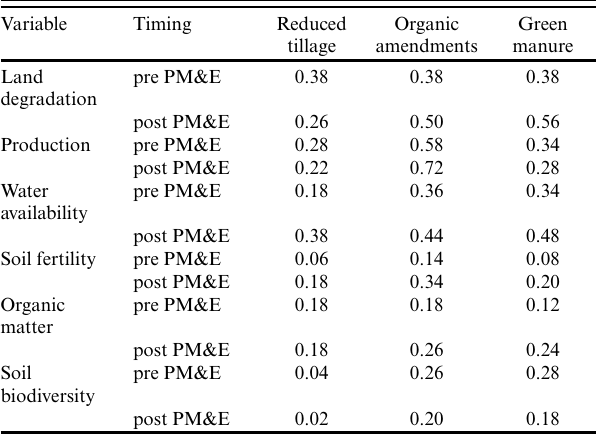
Table 4. Influence, or strength of relation, of the three most common regenerative agriculture practices on land degradation, production, and the four most central factors as expressed